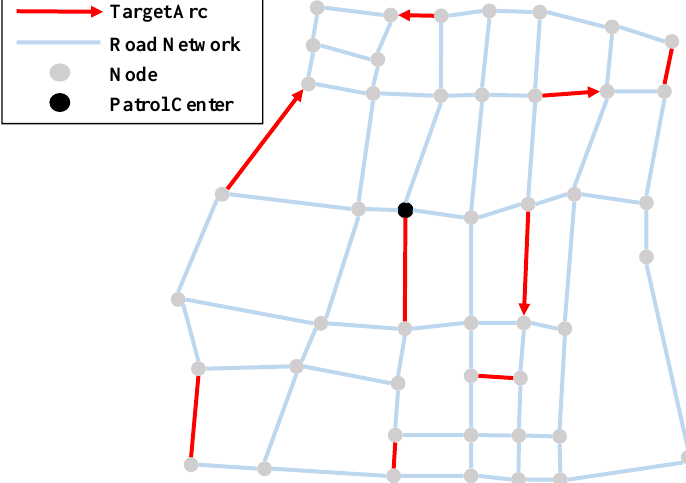
Figure 1. Schematic diagram of the road network and arc tasks. Table 1. Symbols and descriptions.